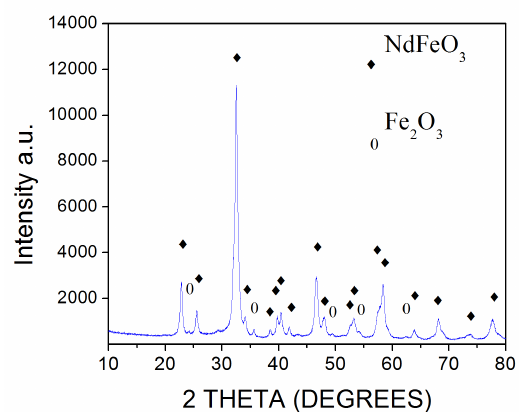
Fig. 4 XRD pattern of powder obtained after 15 h of milling from Nd